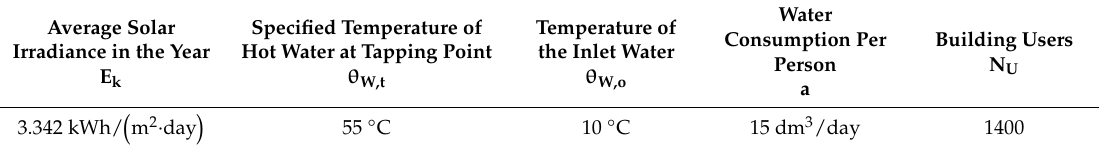
Table 3. Assumptions for a solar collector system.